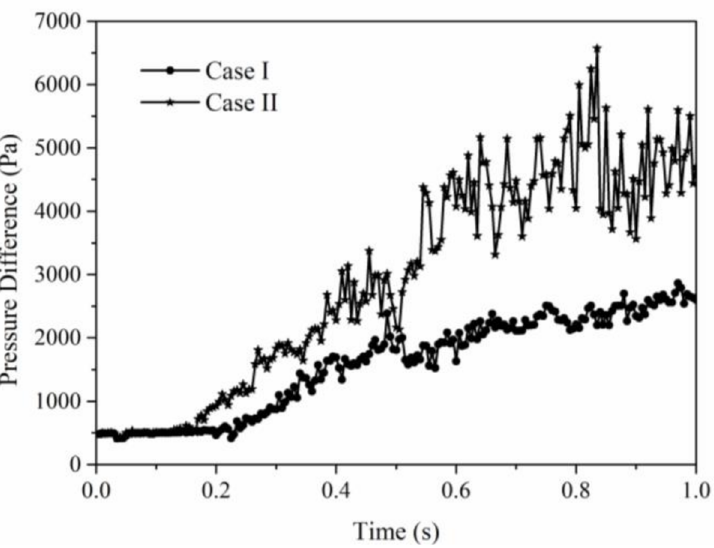
Figure 8. Variation of pressure difference between inlet and outlet with time during continuous injection of large or small